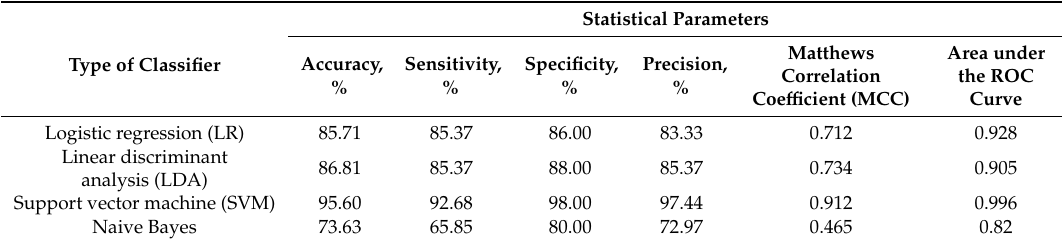
Table 4. Performance of classifiers by combining spectrophotometry and HFUS imaging techniques.